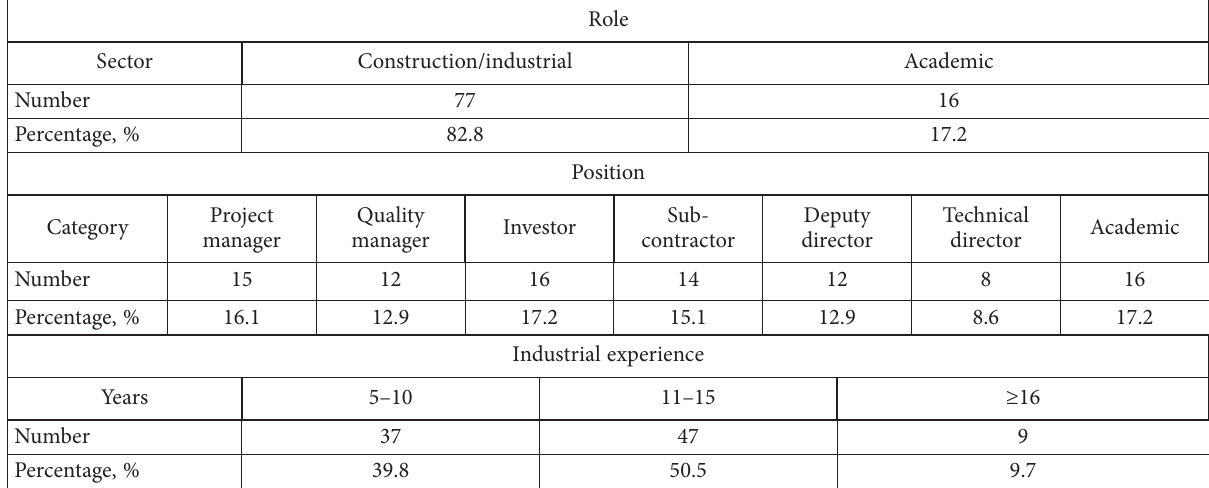
Table 4. Background characteristics of the respondents